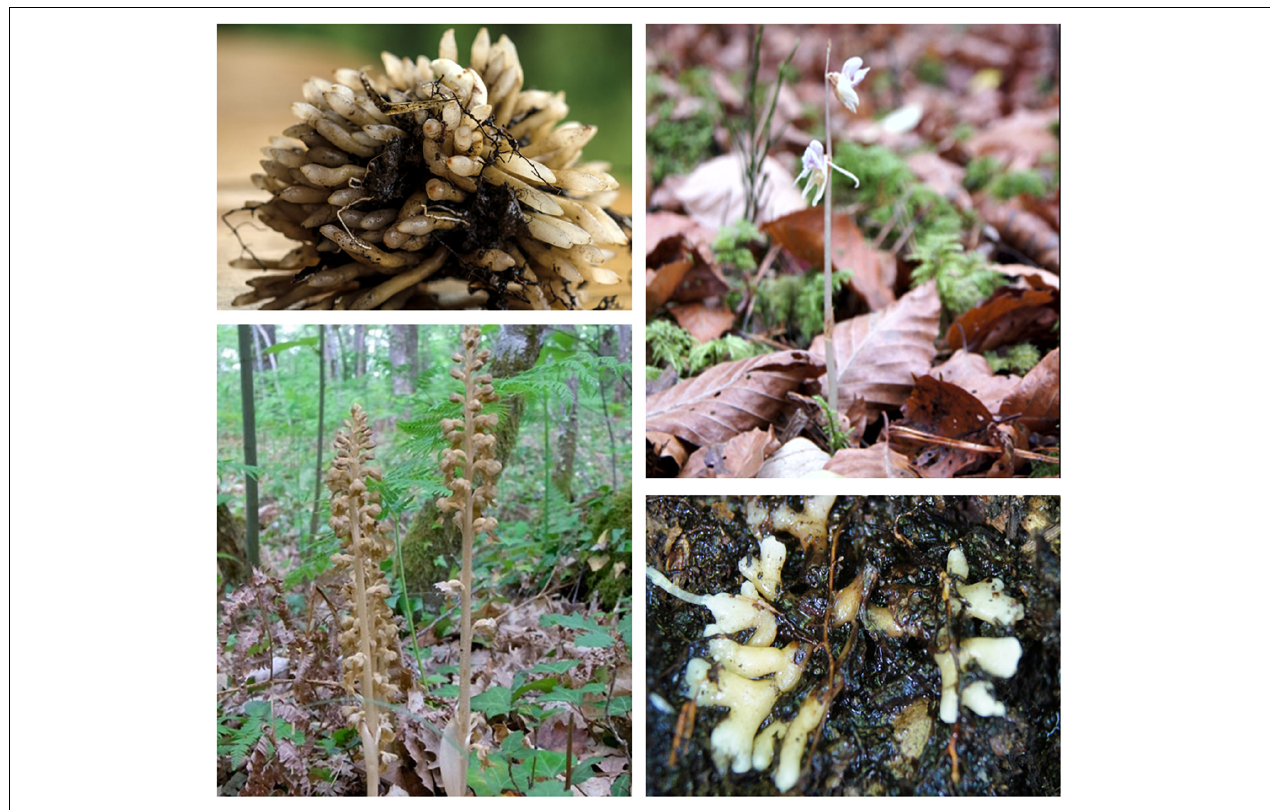
FIGURE 1 | Morphology of Neottia nidus-avis and Epipogium aphyllum . Top left: roots of N. nidus-avis . Bottom left: inflorescence of N. nidus-avis . Top right: inflorescence of E. aphyllum (Courtesy of Emilia Krawczyk). Bottom right: rhizome of E. aphyllum (Courtesy of Emilia Krawczyk).